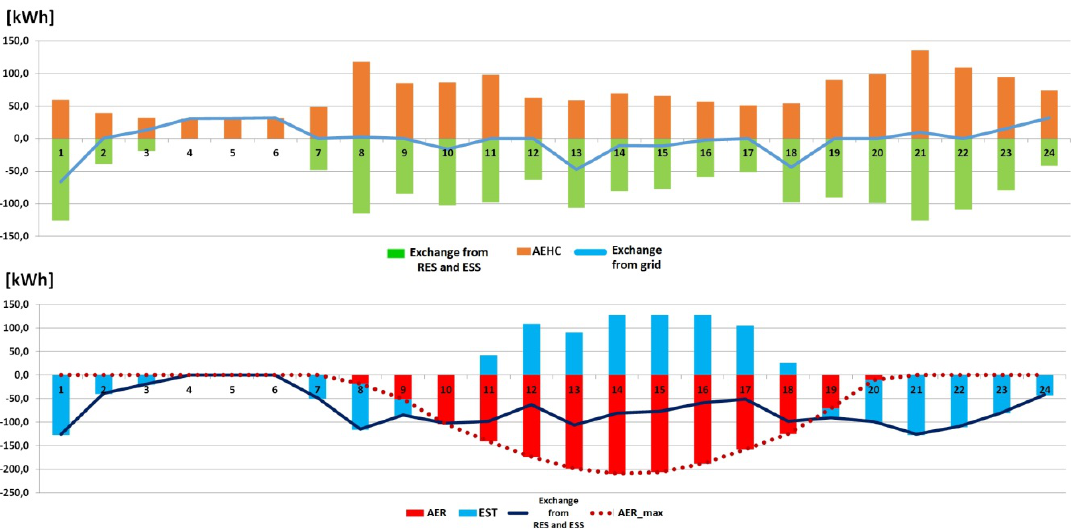
Figure 14. Energy management during the simulation day under the type-B self-consumption scheme, with an ESS configuration.